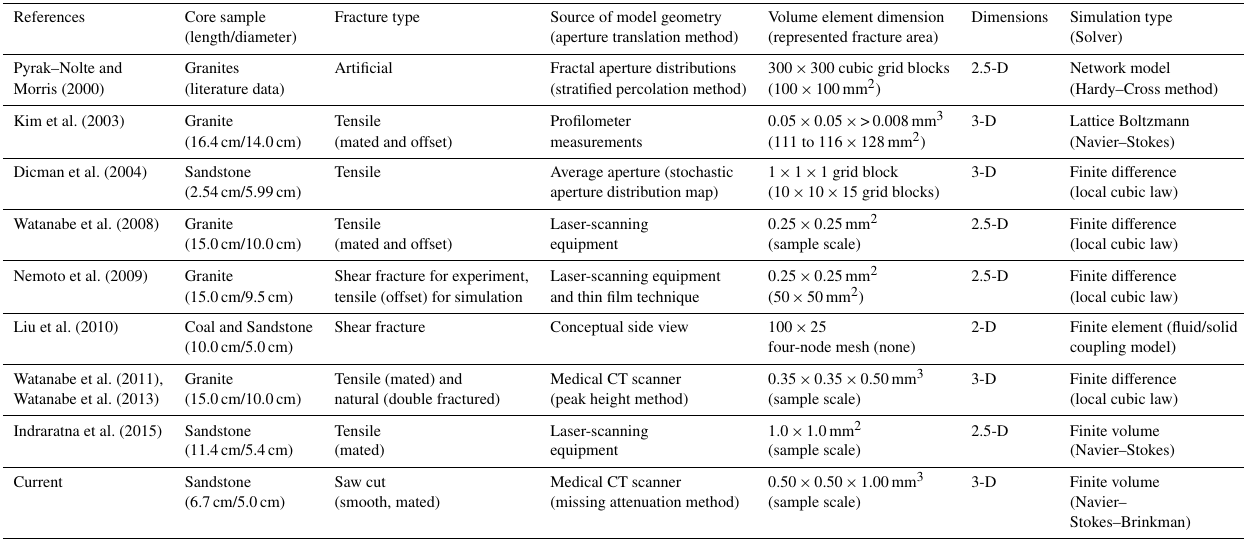
Table 1. Numerical simulations of stress-dependent single-phase fracture flow considering the sample and fracture type, the method to reproduce fracture apertures, the model dimensions and simulation